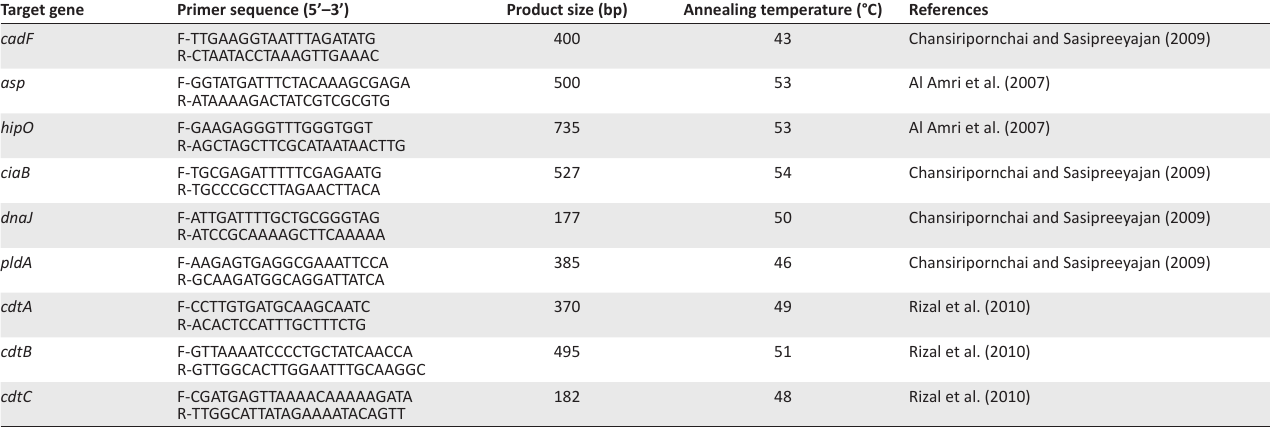
TABLE 1: Target virulence genes, primer sequences, amplicon sizes and annealing temperatures. Target gene Primer sequence (5’–3’)